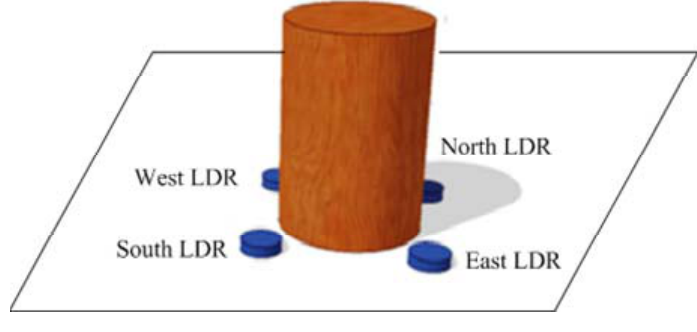
Figure 5. Solar sensing device with a four-quadrant LDR